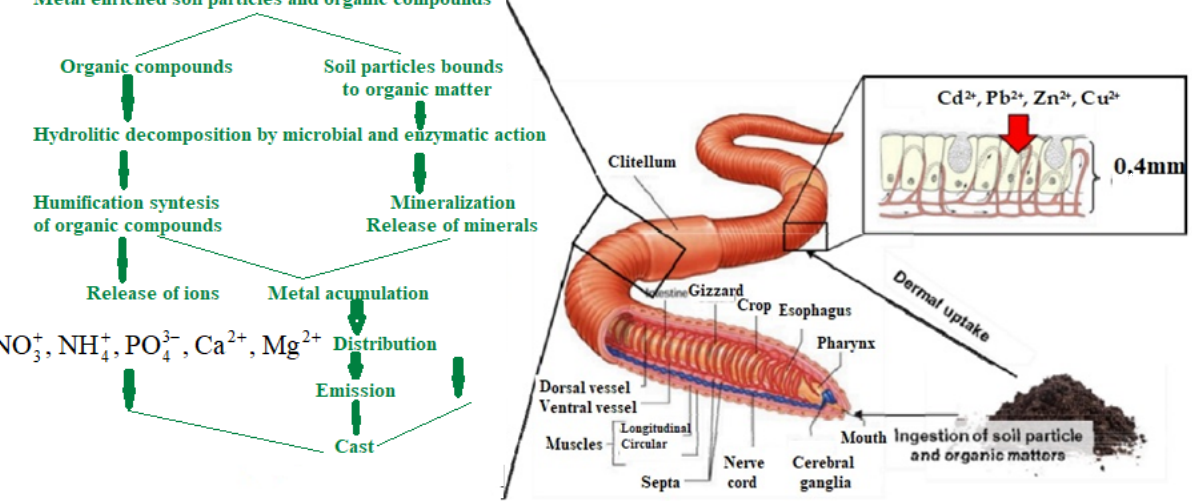
Figure 1. The process of vermicomposting by earthworms (adapted from [36]).